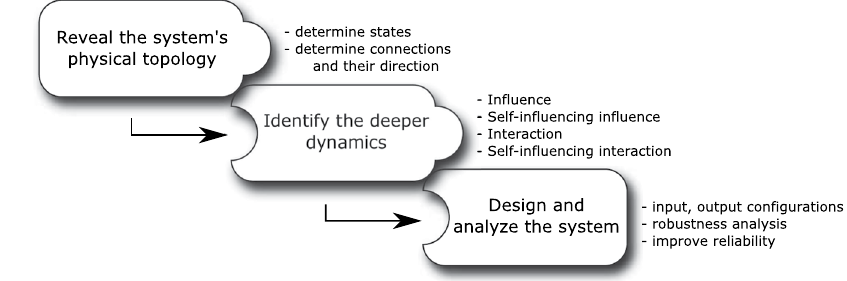
Figure 7. Determined flowchart for system design and analysis. Since connection types can be determined according to the topology of the systems, we strongly recommend following the proposed workflow and taking into account deeper dynamics to obtain more accurate and reliable